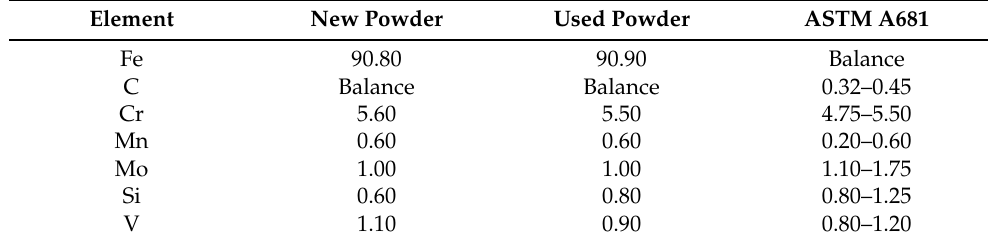
Table 2. EDX Chemical composition of H13 powder [wt%].